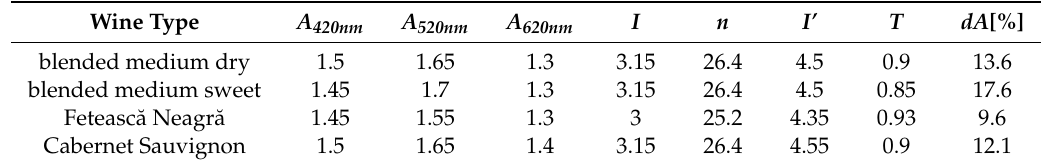
Table 4. Red wine absorption spectrum magnitudes and the estimated wine color measures, determined with the extended sensing area intra-oral